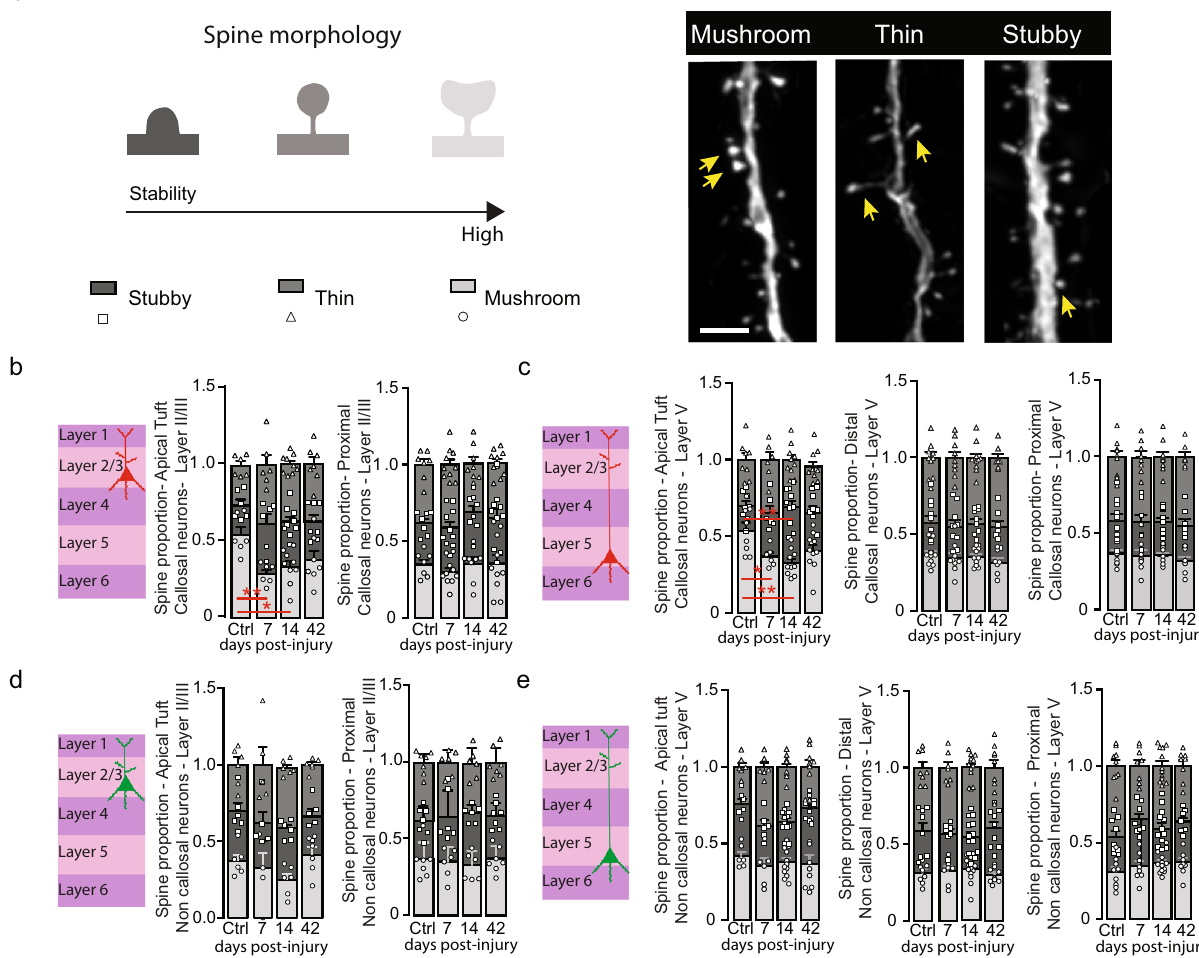
Fig. 3 Callosal neurons display changes in spine morphology following TBI. a Schematic representation of spine morphology and confocal images of mushroom, thin and stubby spines. Yellow arrows represent the examples of the respective spine type. Scale bar: 5 μ m. b Scheme of layer II/III callosal cortical neuron and quanti fi cation (mean ± SEM) of the fraction of mushroom, thin and stubby spines on apical tuft and proximal dendrites of layer II/III callosal neurons. n = 6 – 9 independent dendritic stretches from 4 to 5 mice for Apical and n = 7 – 10 independent dendritic stretches from 4 to 5 mice for Proximal. Apical mushroom spines: p = 0.0040 Ctrl vs7d and p = 0.0102 Ctrl vs 14d. One way-ANOVA and Dunnett ’ s test. c Scheme of layer V callosal cortical neuron and quanti fi cation (mean ± SEM) of the fraction of mushroom, thin and stubby spines on apical tuft, distal and proximal dendrites of layer V callosal neurons. n = 7 – 10 independent dendritic stretches from 4 to 5 mice for Apical, n = 7 – 10 independent dendritic stretches from 4 to 5 mice for Distal, n = 6 – 10 independent dendritic stretches from 4 to 5 mice for Proximal. Apical mushroom spines: p = 0.0271 Ctrl vs7d and p = 0.0015 Ctrl vs 14d. One way-Anova and Dunnett ’ s test. Apical stubby spines: p = 0.0026 Ctrl vs 14d. One way-Anova and Dunnett ’ s test. d Scheme of layer II/III non callosal cortical neuron and quanti fi cation (mean ± SEM) of the fraction of mushroom, thin and stubby spines on apical tuft and proximal dendrites of layer II/III non callosal neurons. n = 5 – 6 independent dendritic stretches from 4 to 5 mice for Apical and n = 6 – 7 independent dendritic stretches from 4 to 5 mice for Proximal. e Scheme of layer V non callosal cortical neuron and quanti fi cation (mean ± SEM) of the fraction of mushroom, thin and stubby spines on apical tuft, distal and proximal dendrites of layer V non callosal neurons. (light gray: mushroom spines, dark gray: stubby spines, medium gray: thin spines). n = 6 – 12 independent dendritic stretches from 4 to 5 mice for Apical, n = 7 – 13 independent dendritic stretches from 4 to 5 mice for Distal, n = 8 – 12 independent dendritic stretches from 4 to 5 mice for Proximal. Statistical p values are always compared to control (Ctrl) values. Source data are provided as a Source Data fi